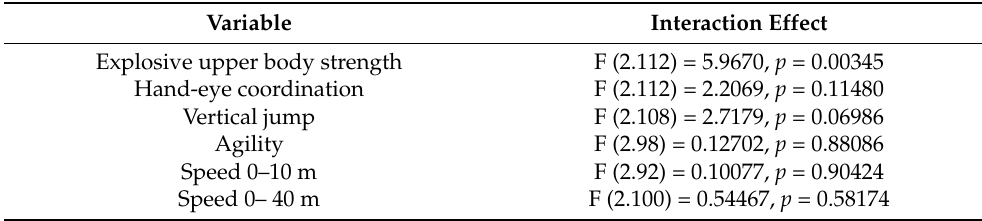
Table 5. Interaction effects between pre- and post-menarche groups over time